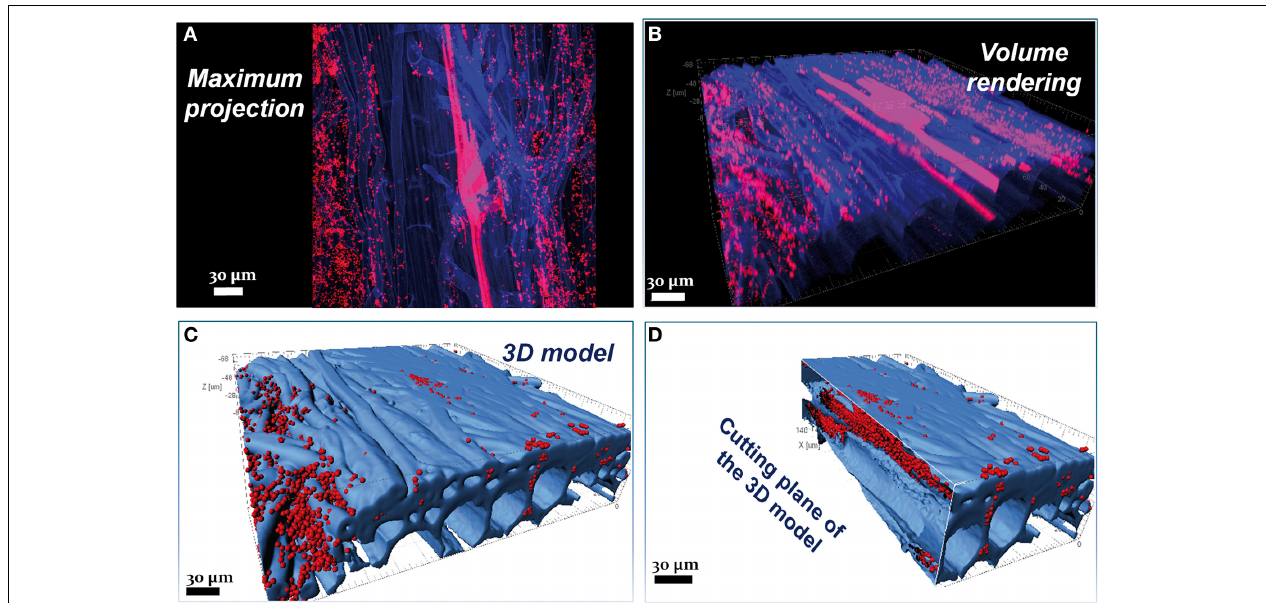
FIGURE 1 | Combination of FISH with autofluorescence. Confocal images showing root colonization by the PGPR Burkholderia terricola ZR2-12 . (A) In the maximum projection it is not possible to assess the colonization pattern of Burkholderia terricola ZR2-12 (red) on this 3 weeks-old sugar beet root (blue); it is impossible as well to discriminate endophytism from ectophytism. (B) The volume rendering of the same confocal stack shows the cells colonizing the internal root tissues but only in the three-dimensional models (C,D) it appears clear that the same bacterium shows a double colonization style: ectophytic at the sides of the